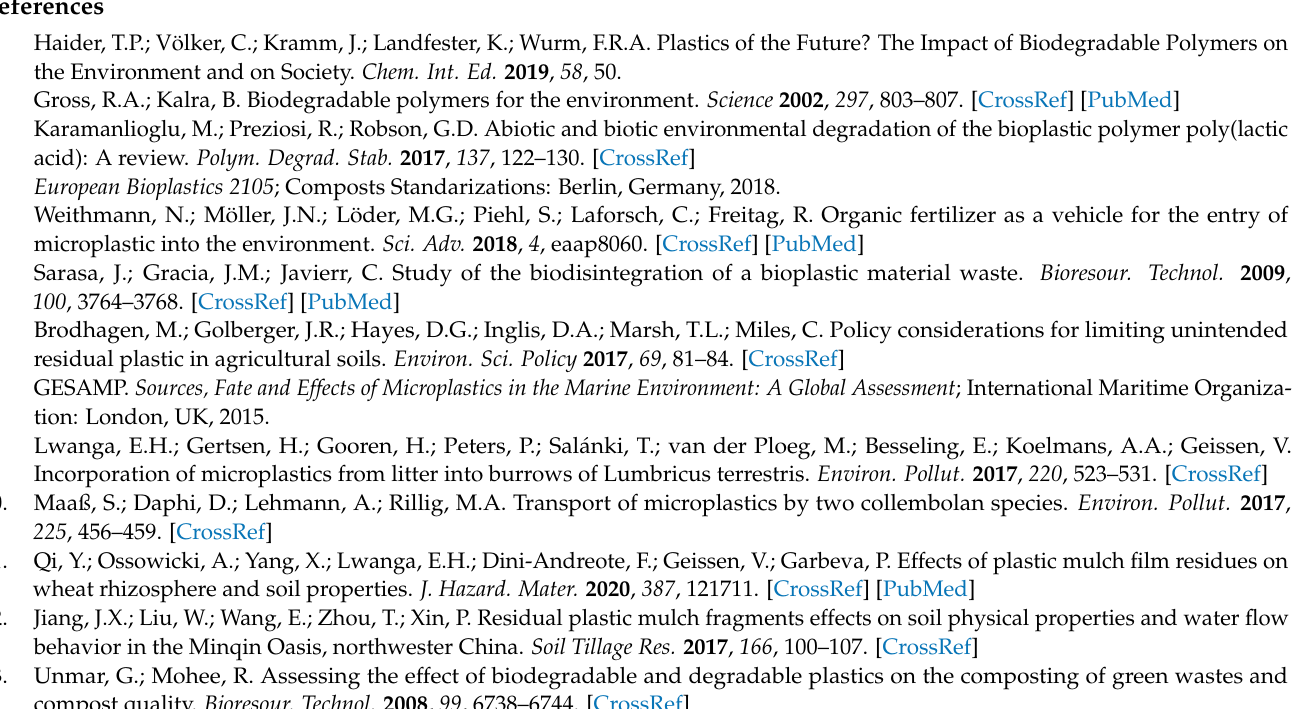
Figure S3. PLA% determination procedure in composts; Figure S4. PLA debris (macro, meso and micro) size distribution; Figure S5. PLA microplastics (particles.g-1 compost); Table S1. PLA % (w.w) per green compost exposed to different composting methods and composting